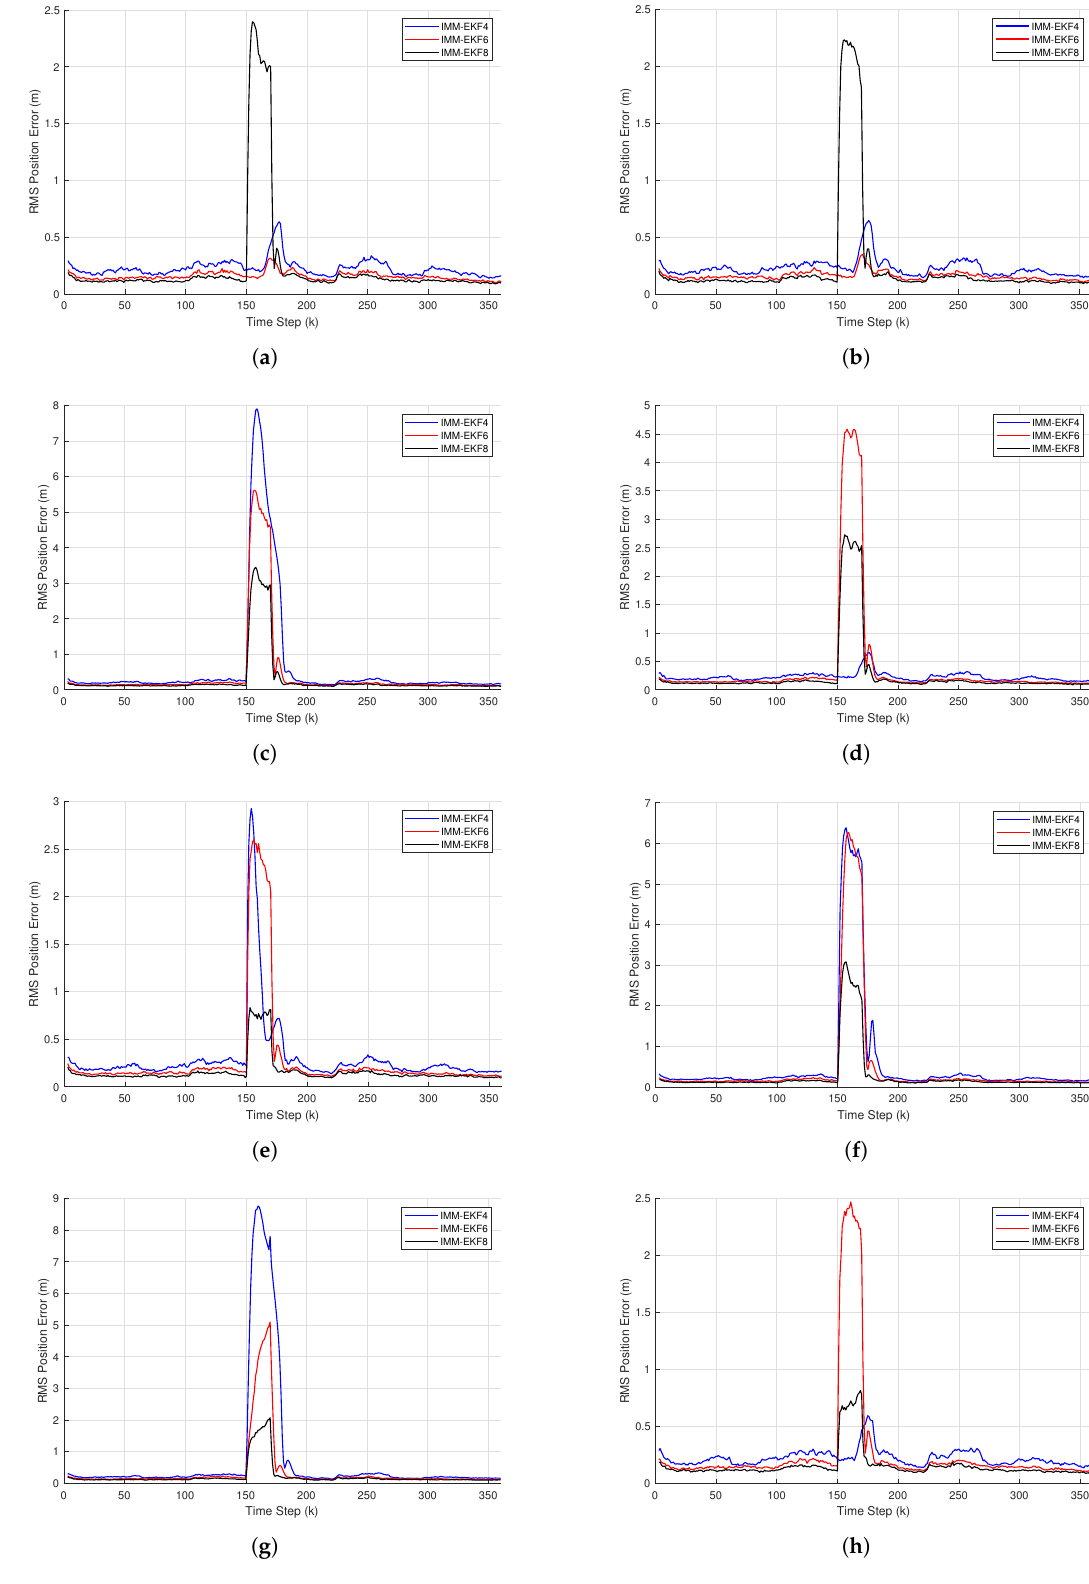
Figure 6. RMS position errors of localization based on IMM-EKFs under temporary NLOS conditions in which the AN in an NLOS was ( a ) AN1, ( b ) AN2, ( c ) AN3, ( d ) AN4, ( e ) AN5, ( f ) AN6, ( g ) AN7 and ( h )